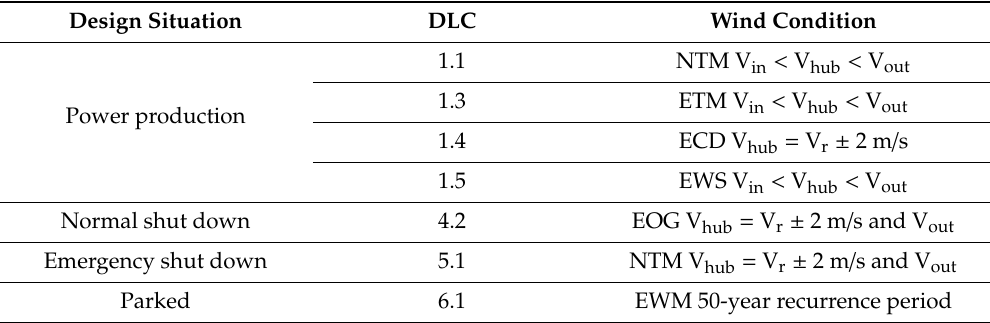
Table 2. Design load cases.